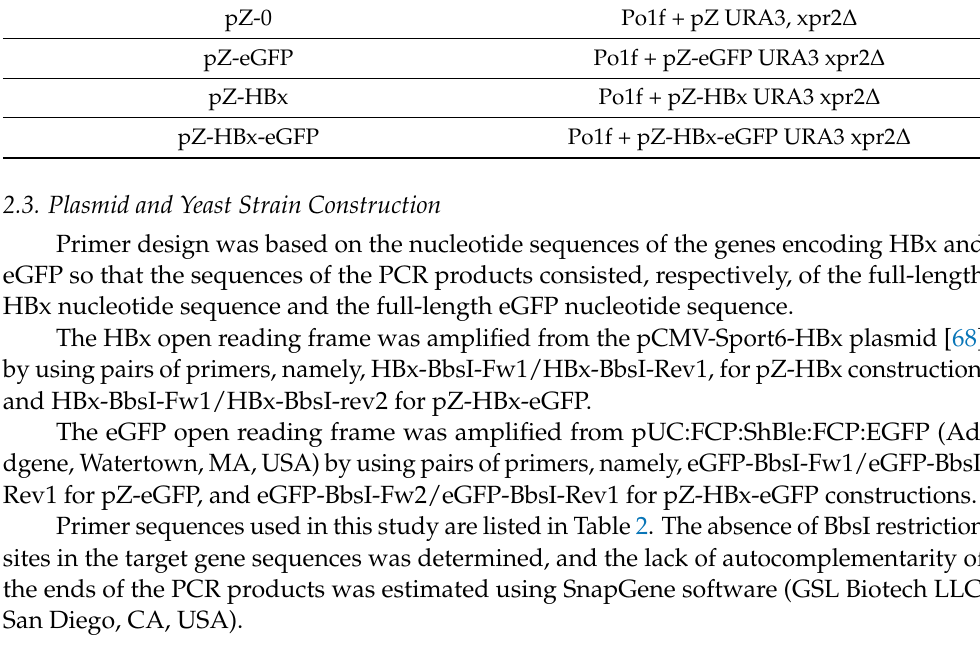
Table 2. List of